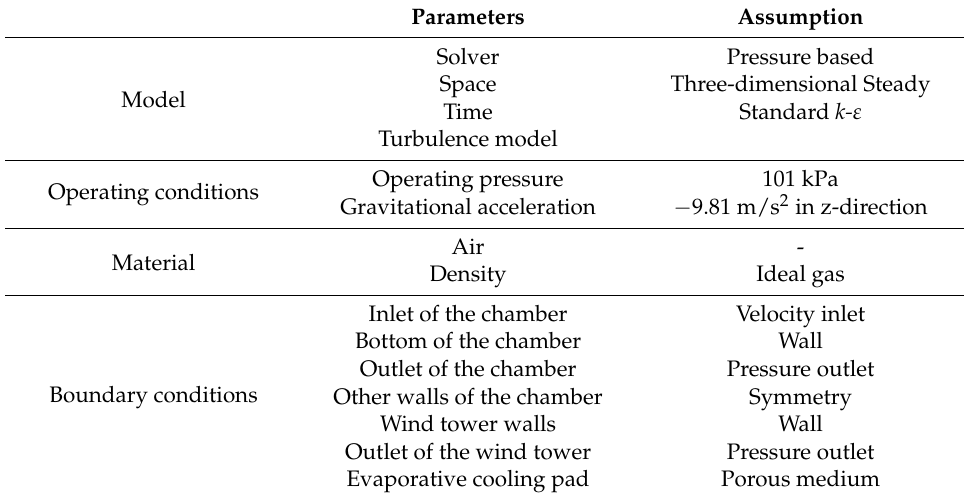
Table 2. Major assumptions used in the CFD